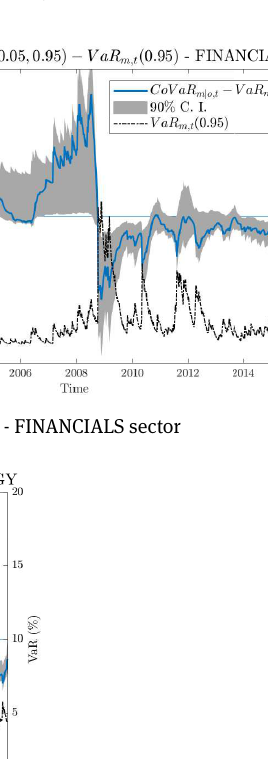
Figure 16c: CoVaR m | o , t (0.05, 0.95) for a certain sector given a bearish scenario for oil prices